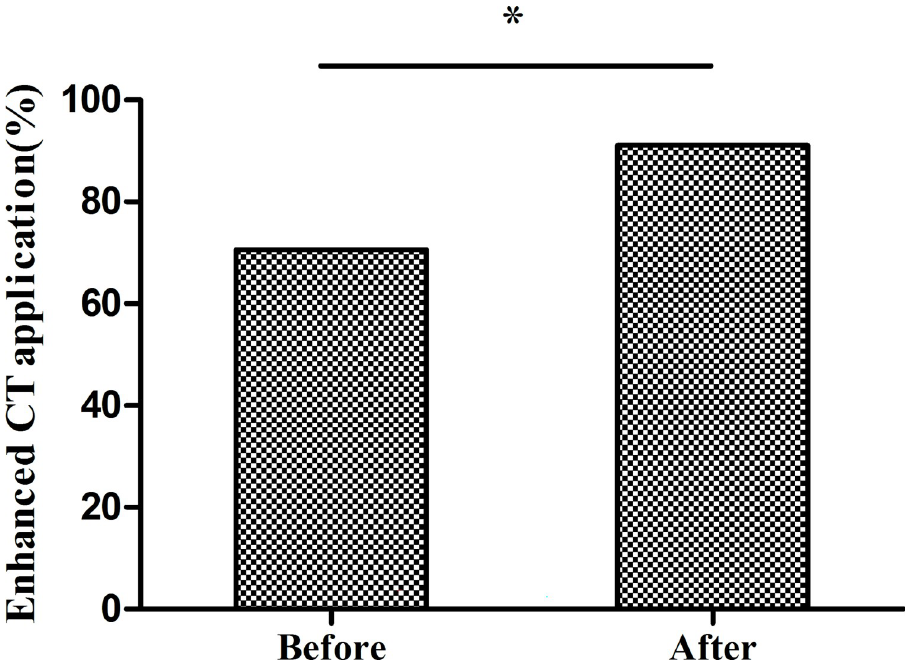
Fig 2. Contrast enhanced CT use before and after program implementation. The proportion of exams using enhanced CT increased from 70.7% to 91.1% after program implementation. ( � p < 0.001 by the chi-square test).